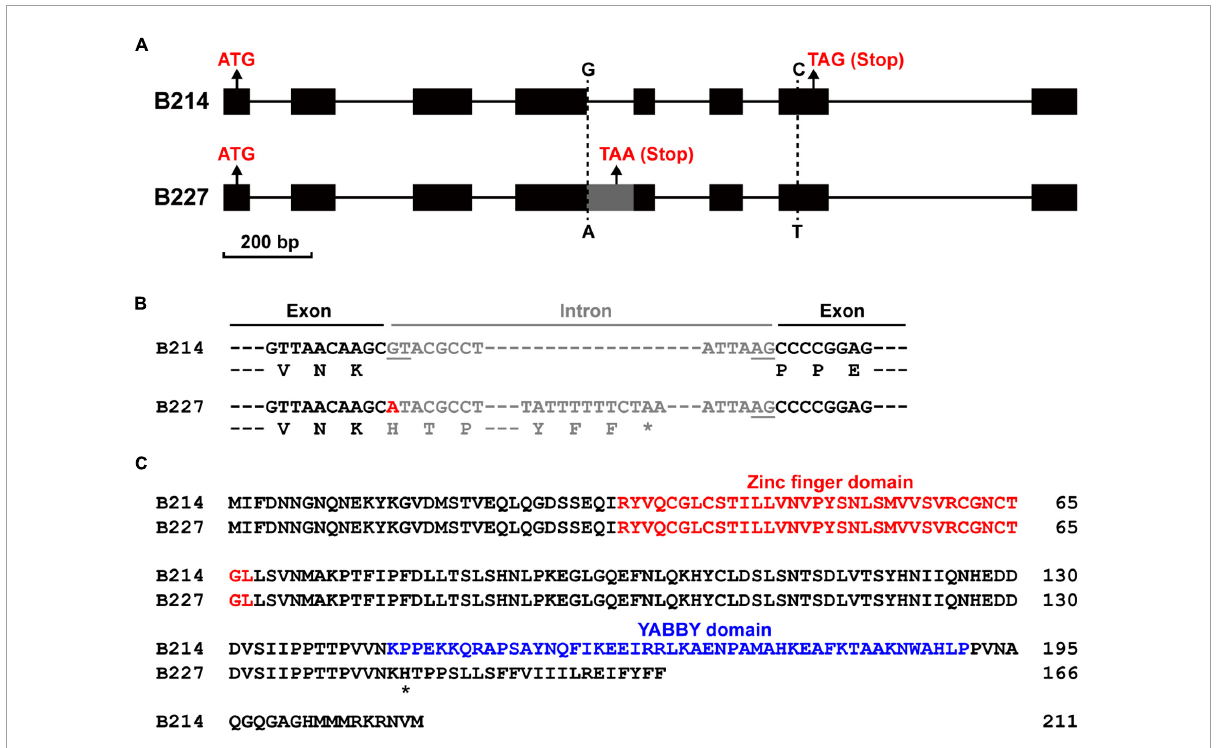
FIGURE3 Mutation sites and amino acid changes in the BhYAB4 gene. (A) Comparison of the gene structure of BhYAB4 between two parental lines. Black boxes, exons; gray box, retained intron; solid lines, introns. (B) Comparison of the coding sequence and predicted protein sequence of BhYAB4 between two parental lines. Exons and introns are shown as black and gray, respectively. Donor (GT) and acceptor (AG) intron splice sites are underlined. The G to A mutation is marked in red. Asterisk indicates the stop codon. (C) Alignment of the predicted protein sequence of BhYAB4 in the parental lines. The zinc finger domain and the YABBY domain are presented in red and blue, respectively. Asterisk indicates the frameshift mutation